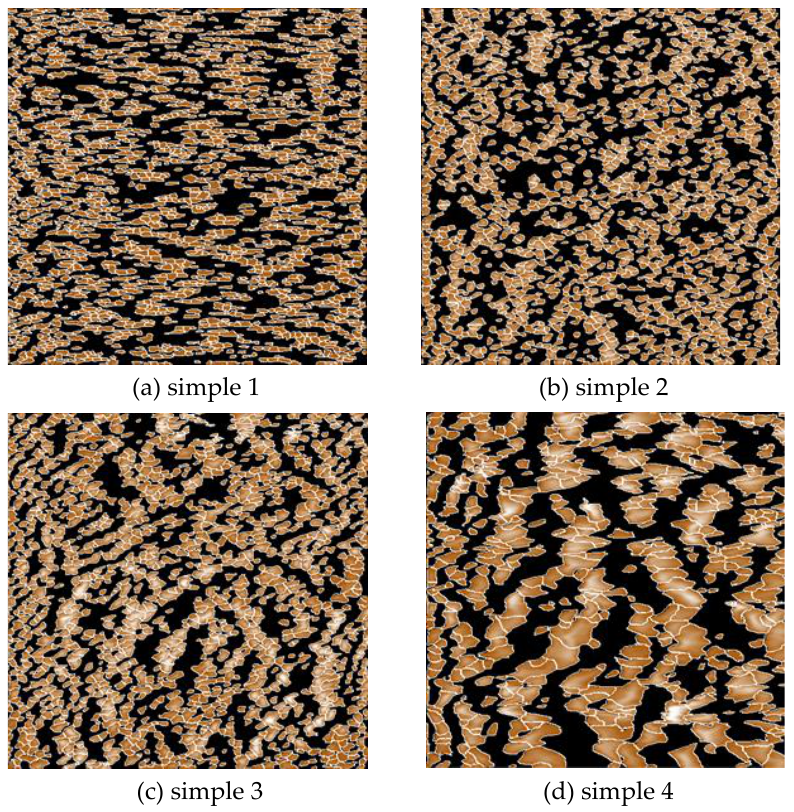
Figure 7. Grain size analysis. ( a ) sample 1, ( b ) sample 2, ( c ) sample 3, ( d ) sample 4.